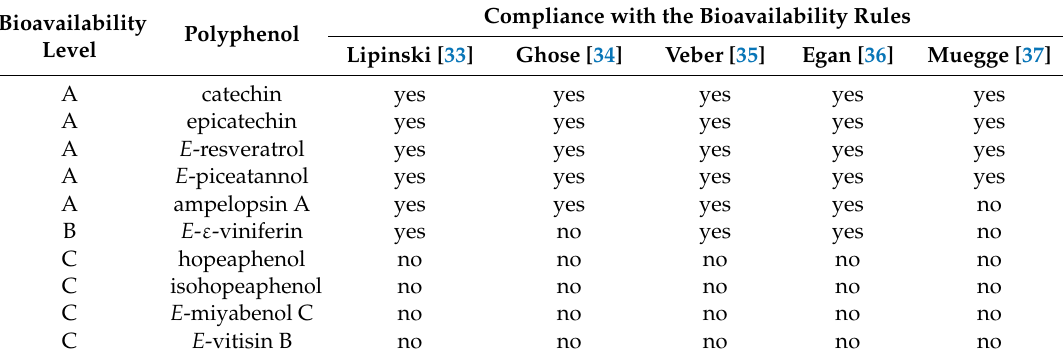
Table 2. Bioavailability levels for GCE components according to their physicochemical properties (A) most potent, (B) medium, (C) less potent to penetrate stratum